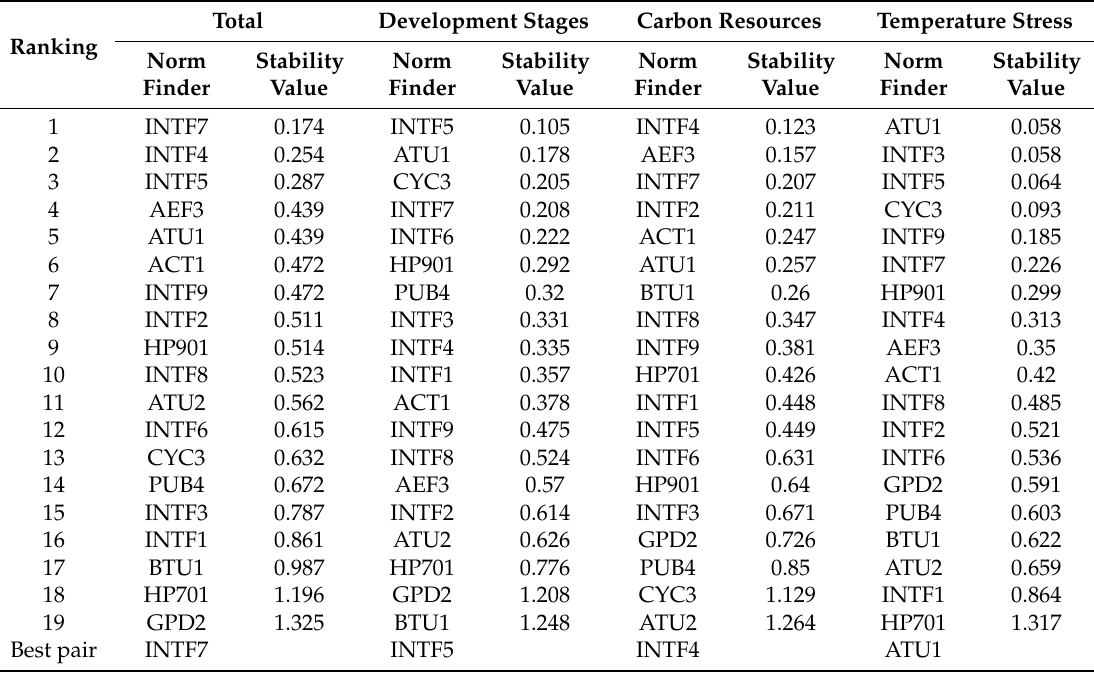
Table 3. Candidate genes ranked by the expression stability calculated by